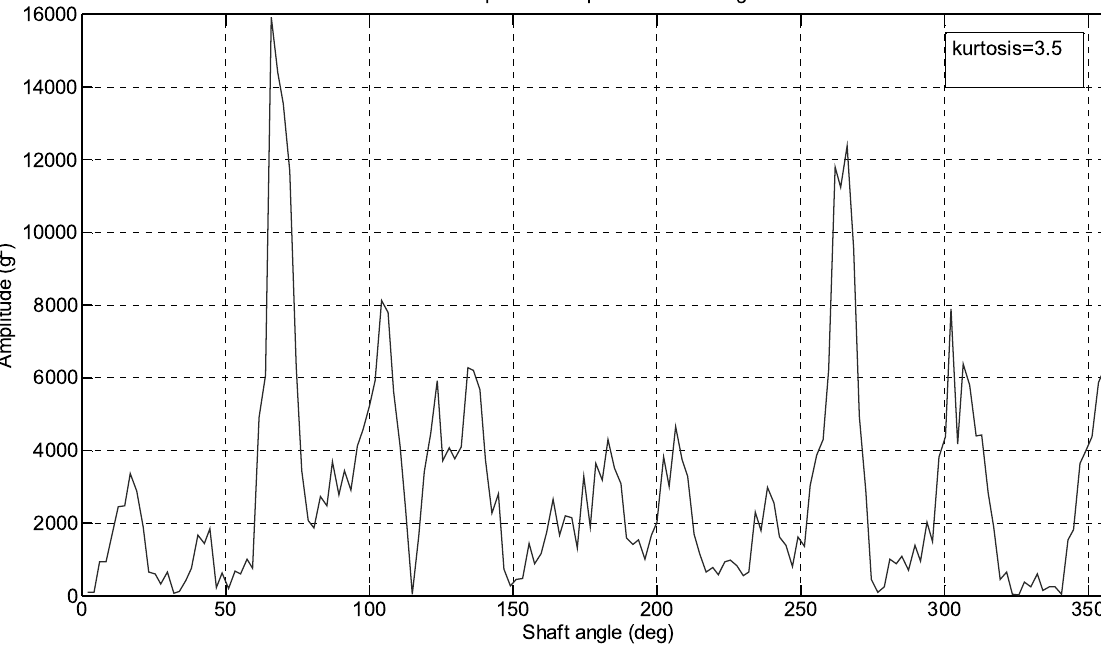
Fig. 14. Envelope of the squared residual signal in the time domain.